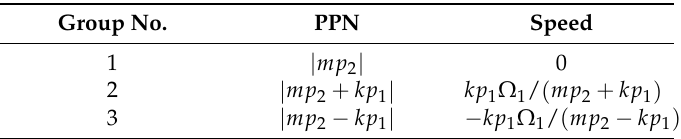
Table 2. Field harmonics excited by the stator PMs. Group